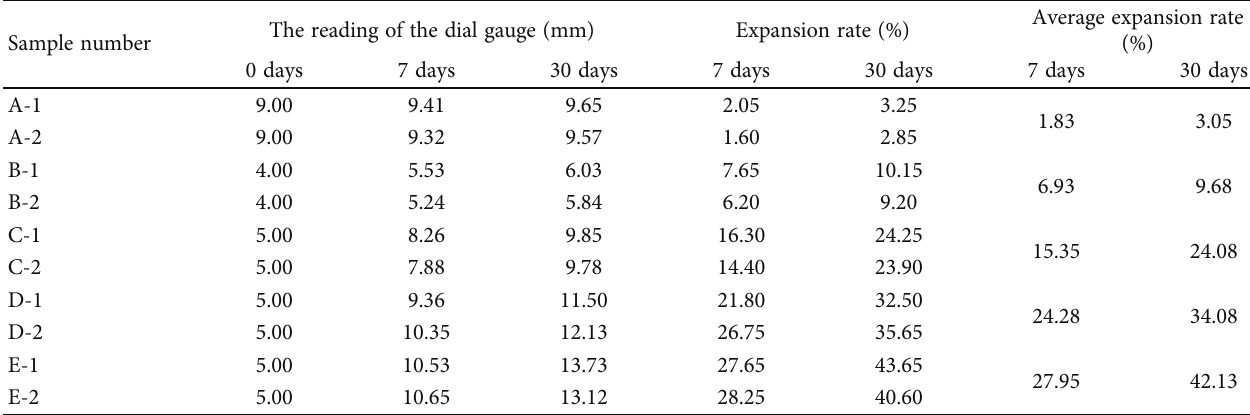
Table 4: Test results of ultimate expansion rate.